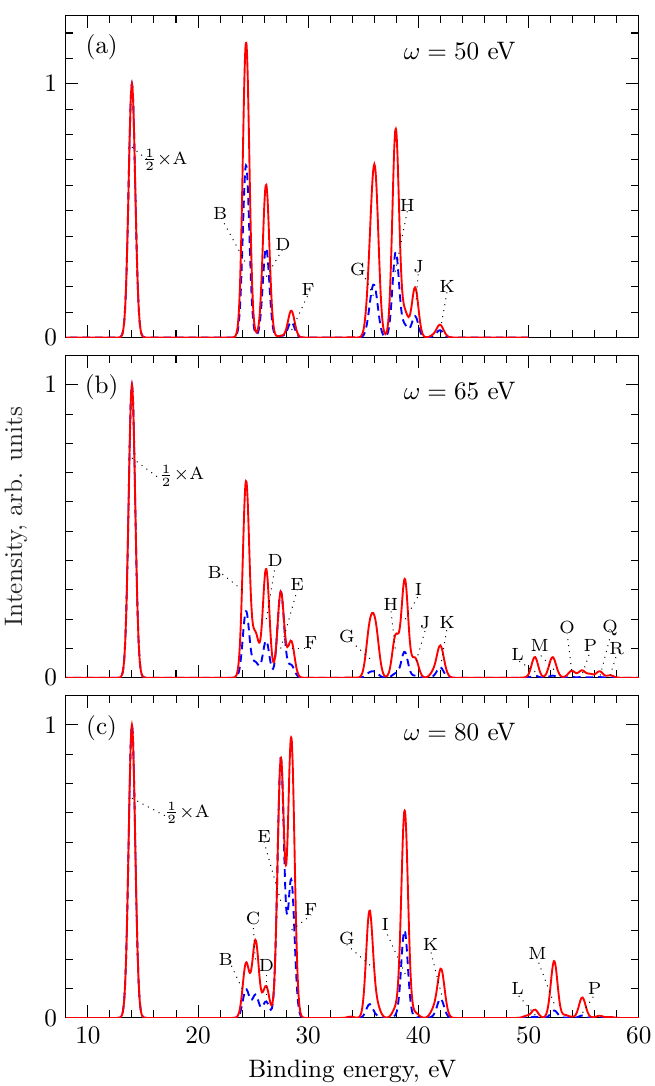
Figure 4. Photoelectron spectrum for different photon energy: ω = 50 eV ( a ), ω = 65 eV ( b ), and ω = 80 eV ( c ). Solid lines: F = 400 ph/Å 2 ; dashed lines: F = 100 ph/Å 2 . The spectra are normalized in such a way that 1/2 of the main line A equals unity. The spectral features are indicated by capital letters in accordance with Table